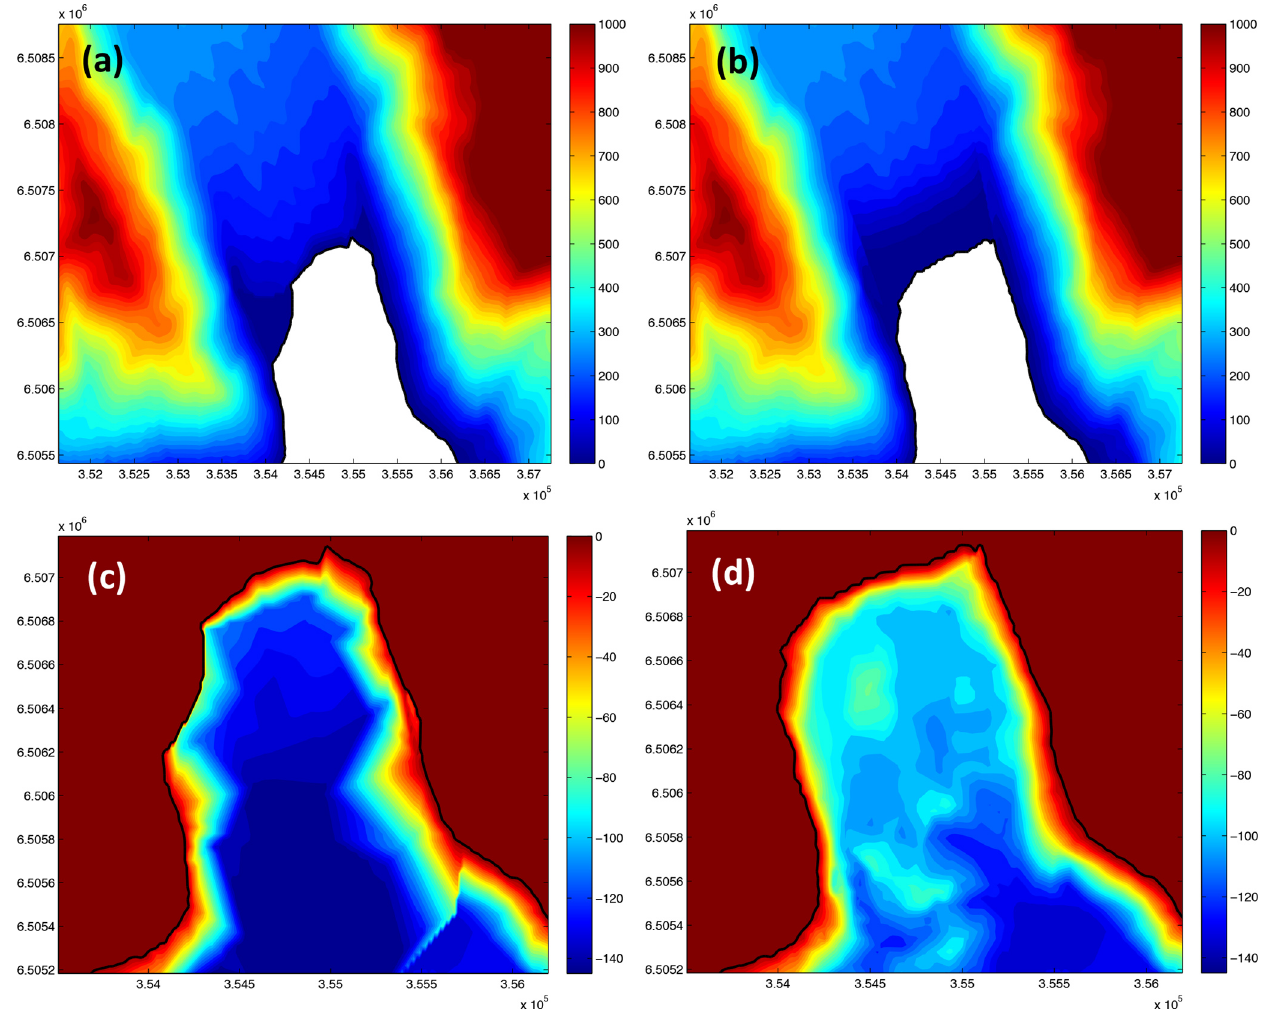
Figure 2. Gilbert Inlet shoreline and glacier, bathymetries, and shorelines before and after 1958. (a) Modified location of shoreline and glacier front before 1958, from Miller (1960). (b) Shoreline and glacier front of Lituya Glacier after the 1958 tsunami. (c) Reconstructed Gilbert Inlet bathymetry (based on 1926 data). (d) Gilbert Inlet bathymetry